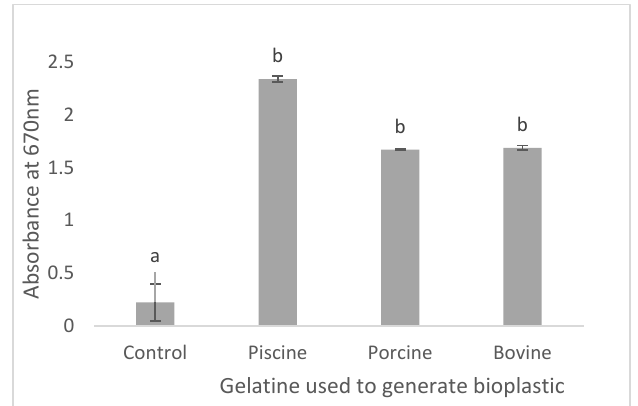
Figure 2. Microalgae ( Phaeodactylum tricornutum ) growth in aqueous solution with different bioplastic treatments. Absorbance at 670 nm represents the density of the solution directly related to microalgae growth (n = 3, error bars represent standard deviation, lowercase letters represent significantly different values).